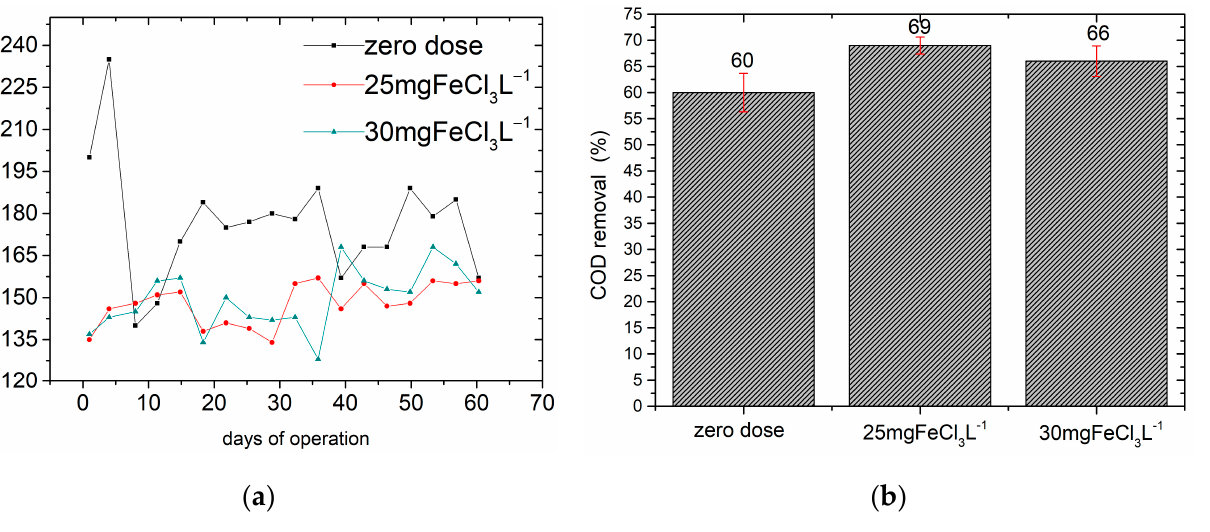
Figure 4. COD e ffl uent pro fi le: ( a ) concentrations; ( b ) percent removal . Figure 4. COD effluent profile: ( a ) concentrations; ( b ) percent removal.